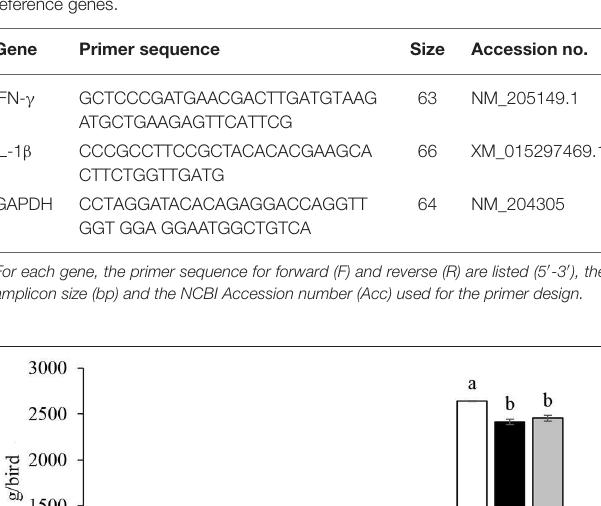
TABLE 1 | Sequences of primer pairs used for amplification of target and reference genes.